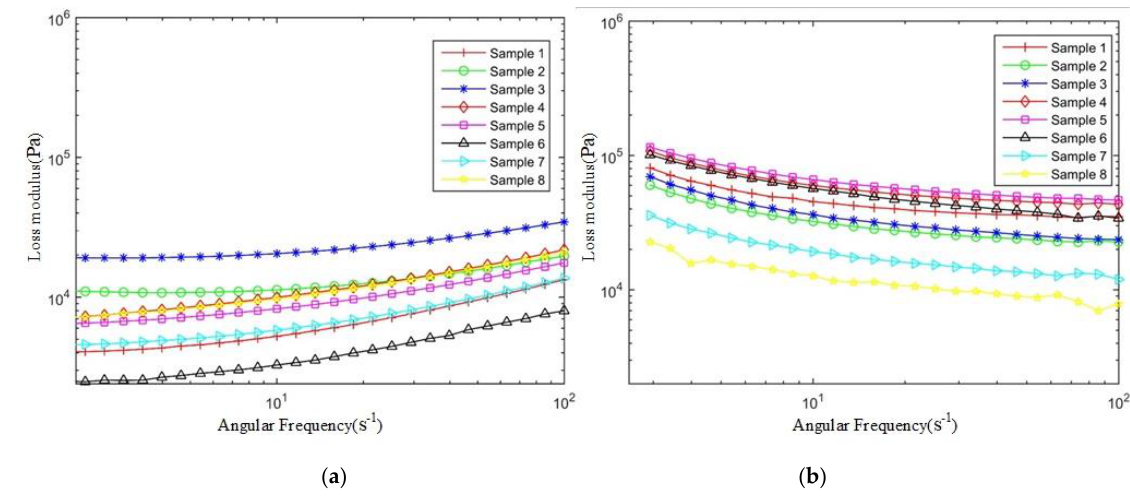
Figure 8. Relationship between loss modulus and angular frequency at a fixed shear strain of 0.1%. ( a ) off-state. ( b ) 1 T.